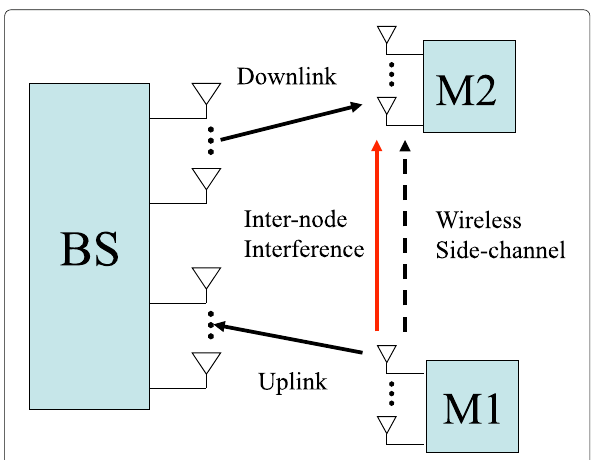
Fig. 1 MIMO full-duplex network: inter-mobile interference becomes an important factor when the full-duplex infrastructure node communicates with uplink and downlink mobile nodes